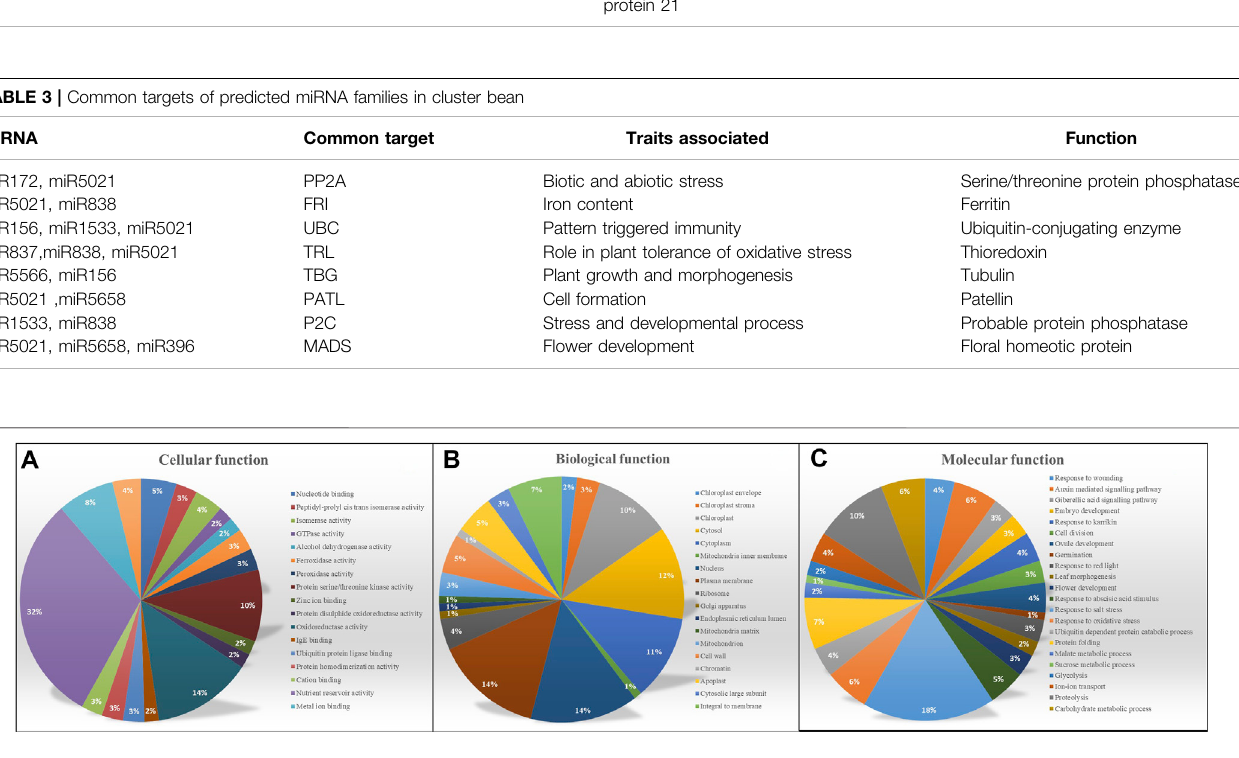
FIGURE 4 | GO annotation for output targets and their distribution in three categories (A) Molecular function (B) Biological process (C) Cellular component.